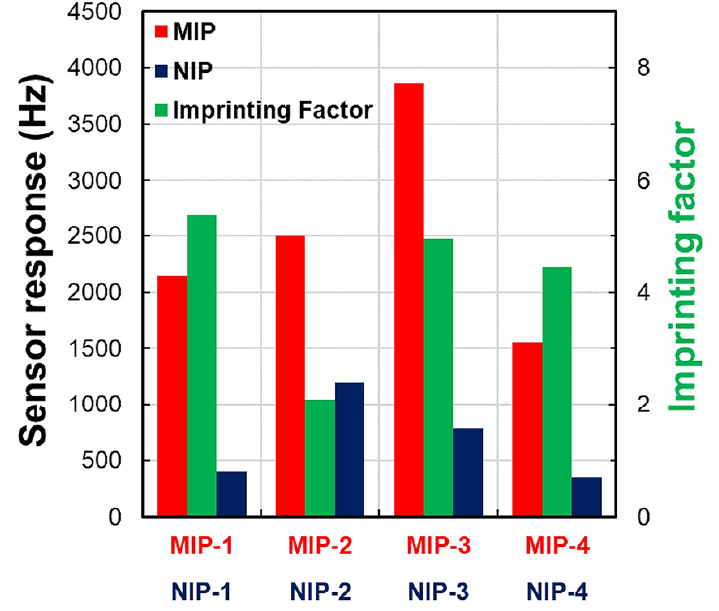
Figure 5. Sensor responses and imprinting factors of QCM devices coated with different MIP formulations. Imprinting factors are calculated by dividing the respective MIP and NIP sensor shifts.